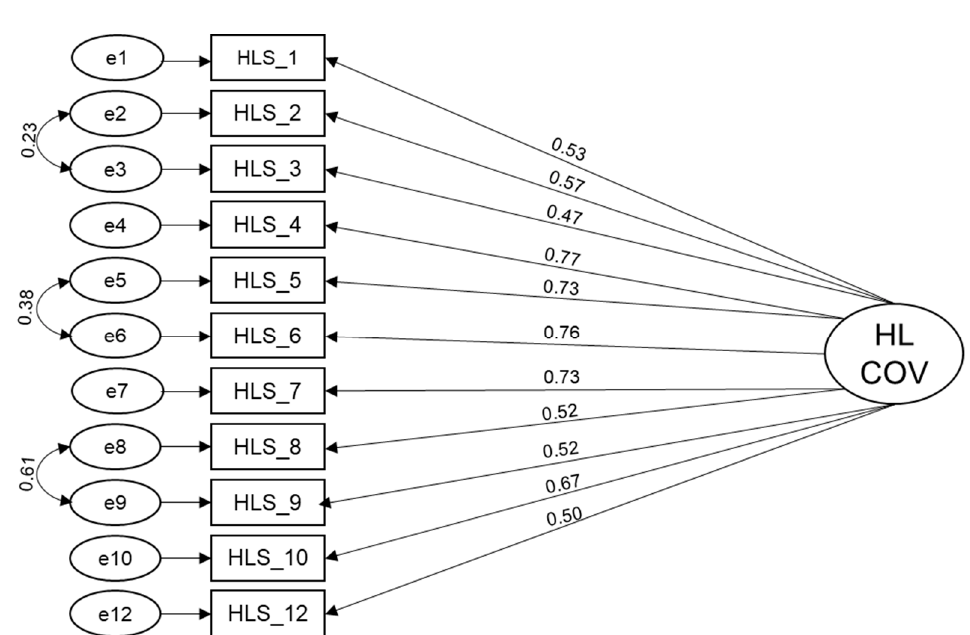
Figure 1. Confirmatory model of the HL-COV-HP instrument ( n = 965).